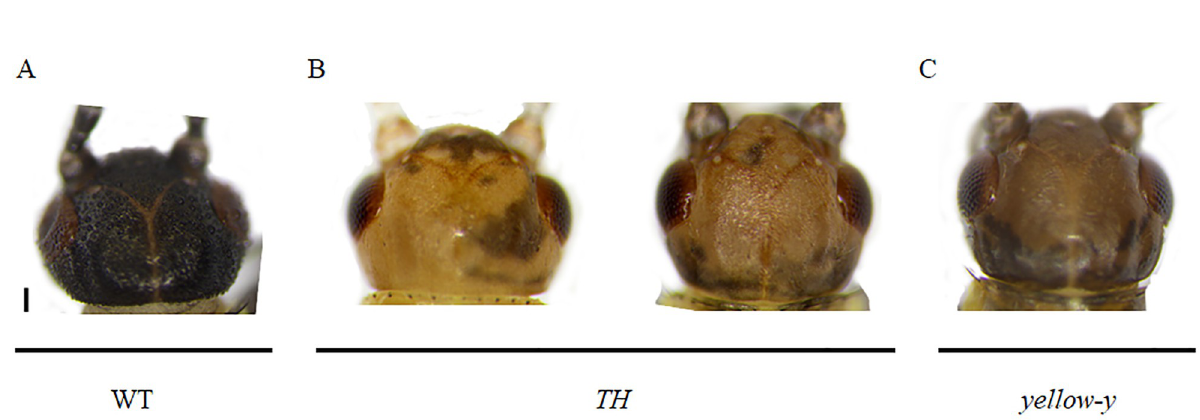
Fig 9. Diagram of pigmentation changes on the head of the G . bimaculatus . (A) WT with black head. (B) TH mutant head pigmentation patterns. (C) The head of yellow-y mutants are mosaic. Bar = 100 um.